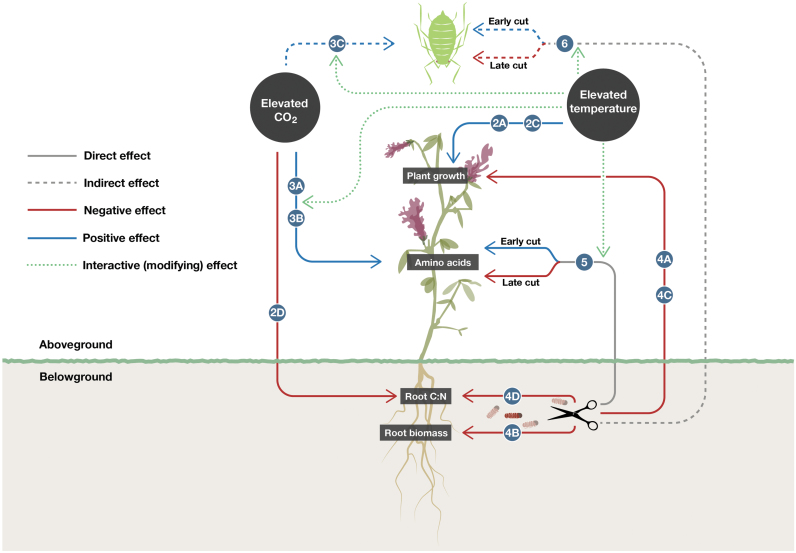
Schematic diagram of the significant positive and negative effects of temperature, CO2, and root cutting treatments on plant characteristics and aphids. Numbers and letters correspond to the figures associated with those effects.